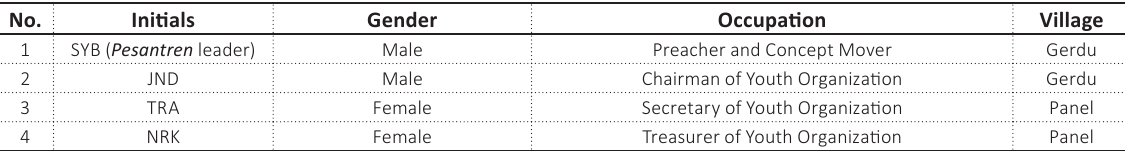
Table 1. List of key informants No.